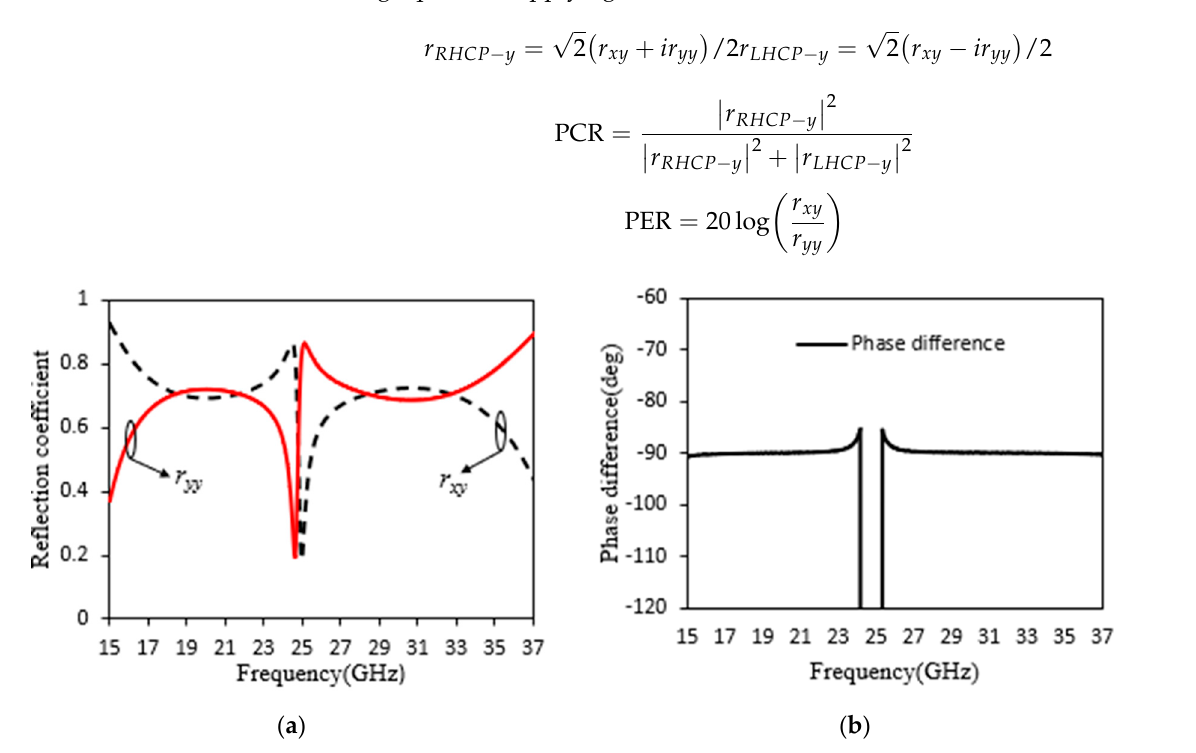
Figure 2. The simulated results of the proposed converter. ( a ) The magnitudes ( r yy and r xy ) and ( b ) phase difference ( ∆ ϕ yx ).